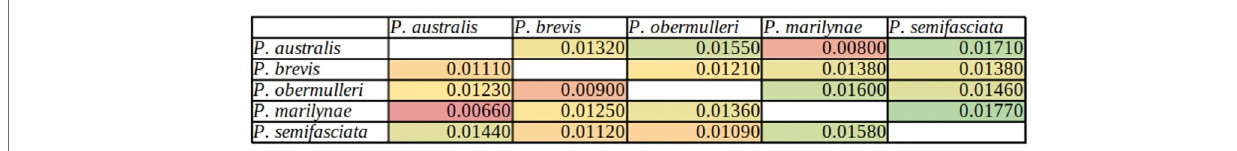
TABLE 3 | AMOVA percentage of variation within and between each of the tested groups: 1) by species, 2) by the best K in the fast structure, 3) by the groups generated in PCoA, and 4) by the presence or absence of sex chromosomes. Clustering Species